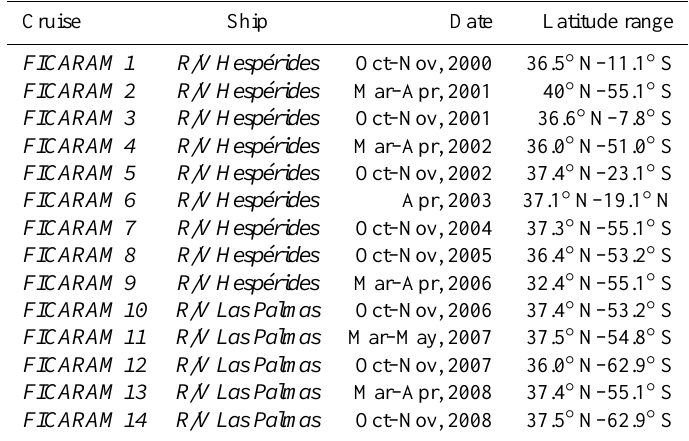
Table 1. Information of the FICARAM